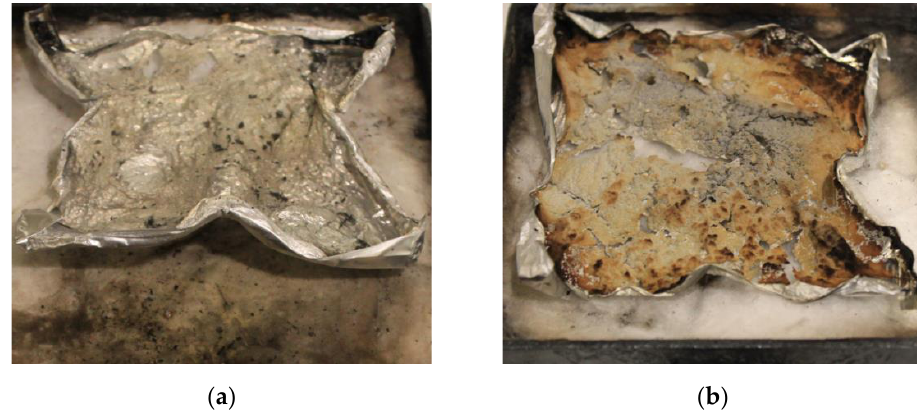
Table 1. The parameters obtained from the cone calorimeter measurement.